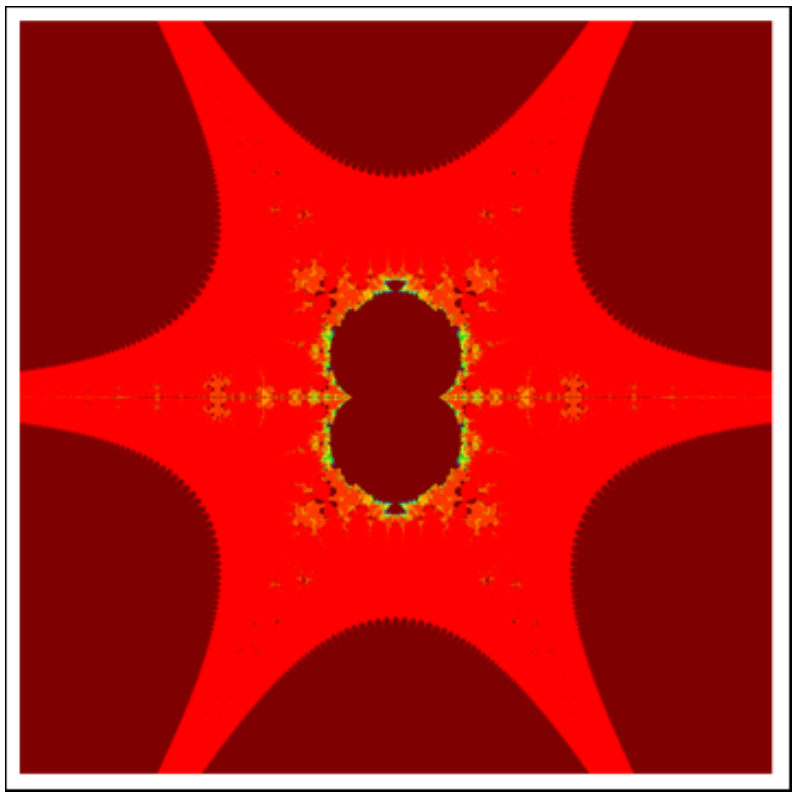
Figure 26. M-set for τ ( z ) = sin ( z 3 ) + c via DKIS. The image execution time is 1315.25 s.